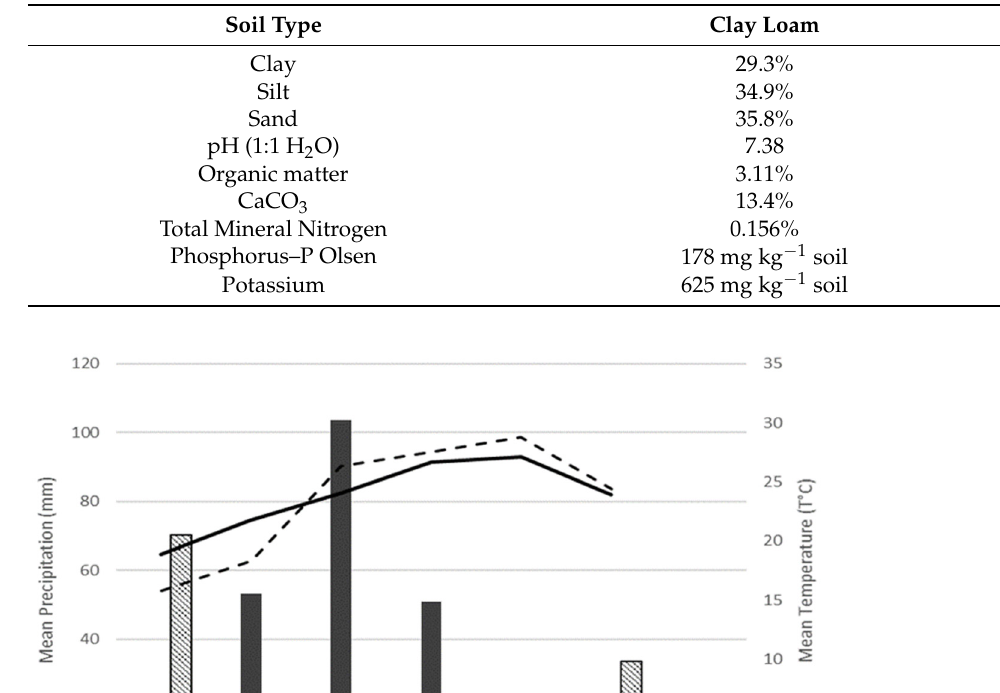
Table 1. Soil properties of the experimental field.